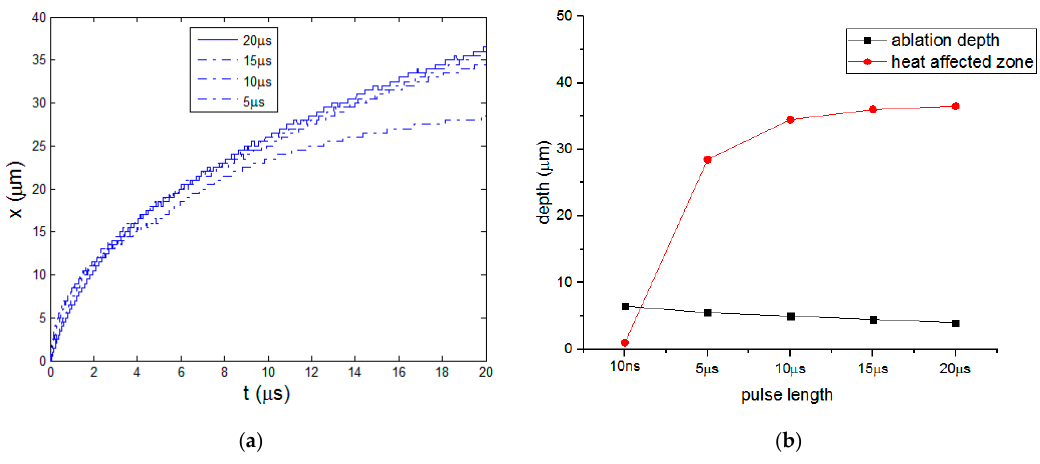
Figure 11. ( a ) Curves of HAZ; ( b ) Ablation depth and HAZ.